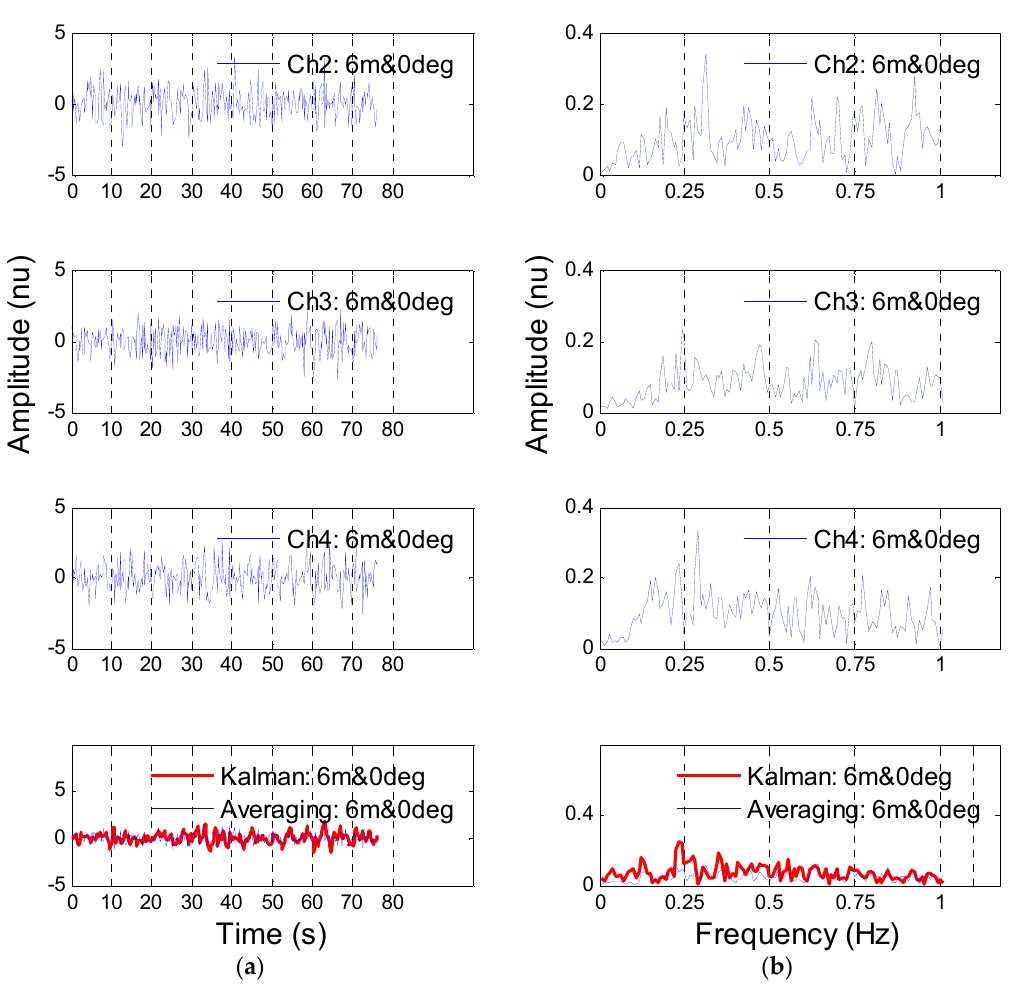
Figure 9. Four waveforms detected by the target association and the data fusion result ( a ) and their corresponding power spectrum in the frequency domain ( b ) when the volunteer was measured at the position (6 m, 0°). The rows from top to bottom are the waveforms from channel 1, 2, 3, 4 and the detected respiration, respectively. The detected respiration was fused by two methods: one is the Kalman filtering proposed in this paper and the other is a simple method based on averaging all four waveforms.